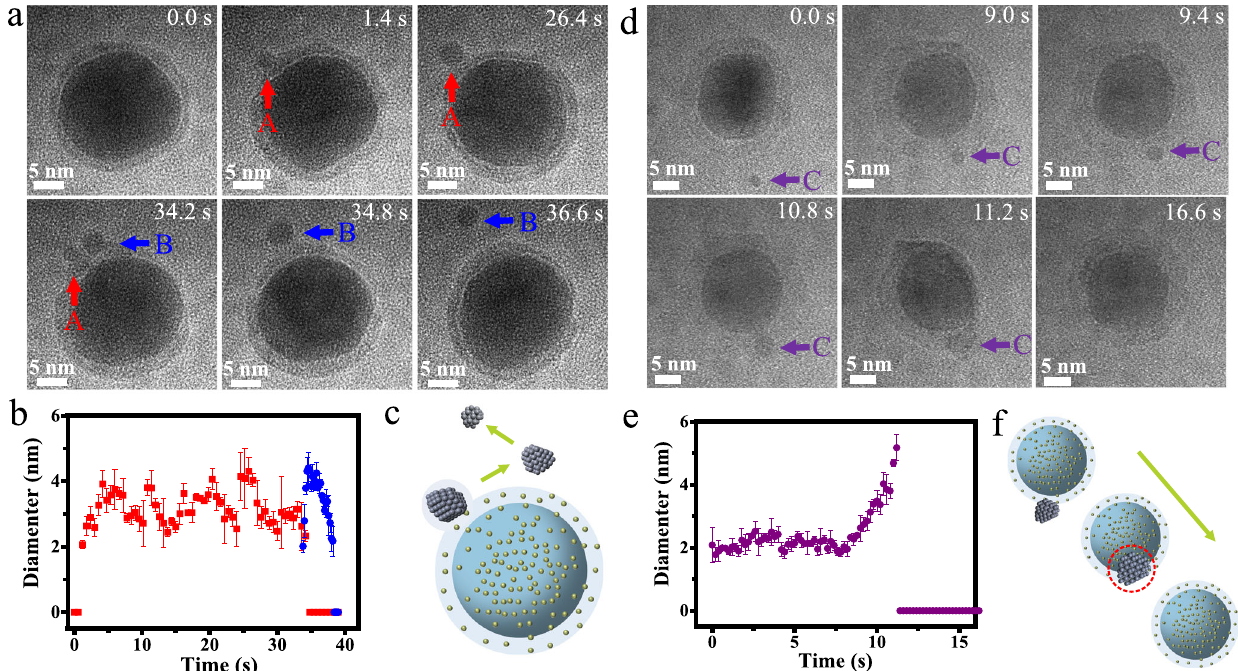
Fig. 3 Dynamic behavior and mass transfer process via the quasi-liquid phase. a Sequential in-situ TEM images showing the nucleation and dissolution of In nanoclusters in the quasi-liquid phase. b Time-dependent changes of the diameter of nanocluster A (red) and nanocluster B (blue) in a . c Schematic illustration of the nucleation of an In nanocluster from the interphase. d Sequential in-situ TEM images illustrating the coalescence process between the quasi-liquid phase and a small In nanocluster. e Time-dependent changes of the diameter of nanocluster C in d . f Schematic illustration of the coalescence process between the interphase and In nanocluster. The light blue shading and dark spheres in c and f represent interphase and In nanoparticles. The green arrows in c and f indicate the reaction direction. The error bars in b and e represent the difference between each set of data (three sets of data are measured at different positions of the same particle) and averaged diameter of small In cluster. Source data are provided as a Source Data fi